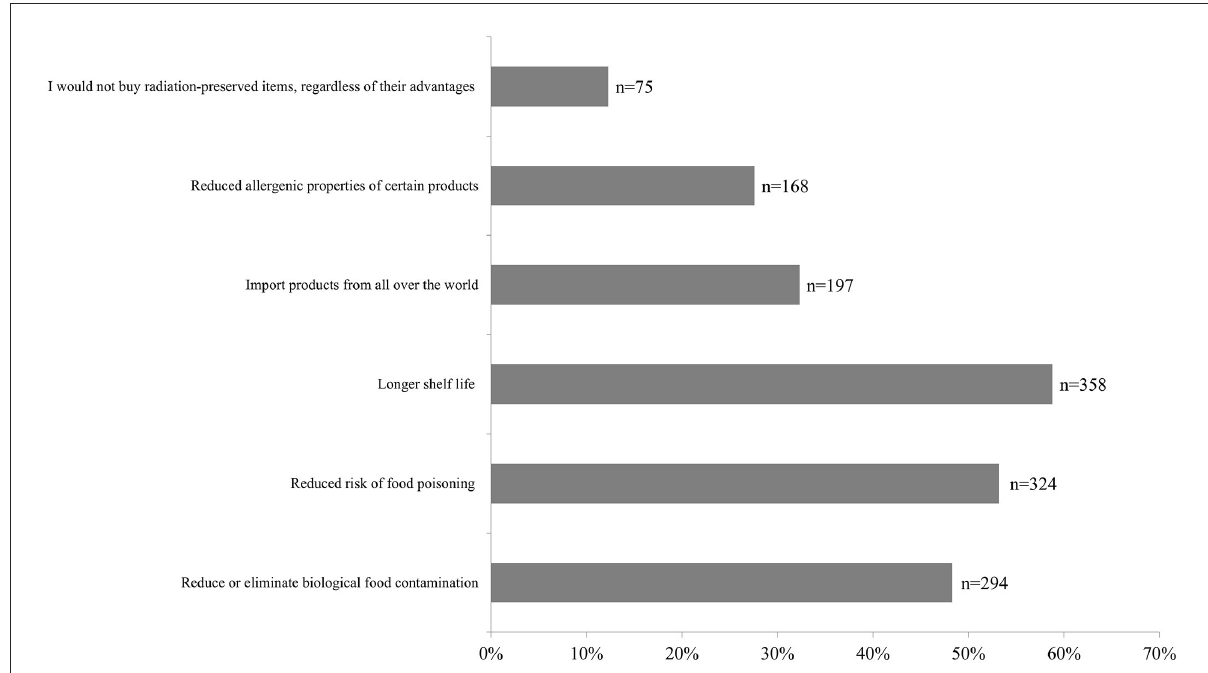
FIGURE4 Advantages of the irradiation process that could be relevant when purchasing irradiated products: results after providing educational materials ( multiple choice question